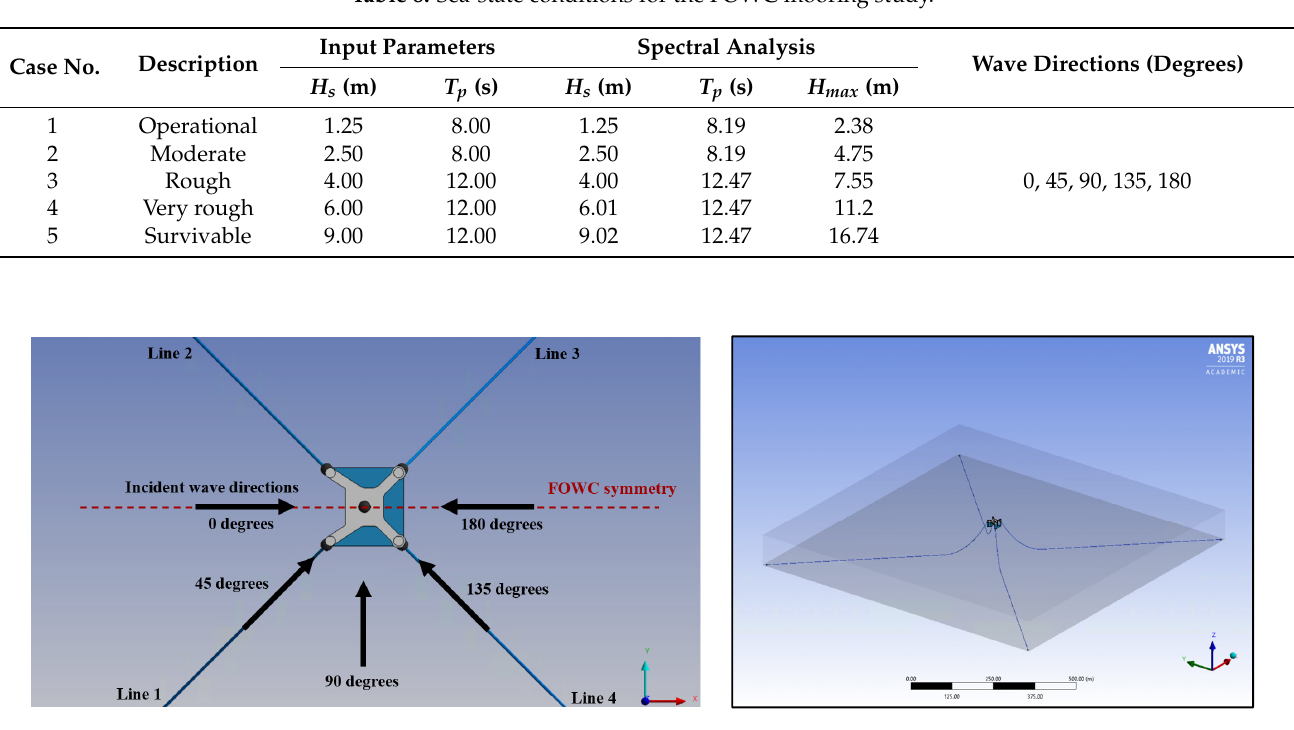
Table 9. Maximum tension (kN) in the mooring lines over a 3 h storm duration and under varied incident wave directions and sea